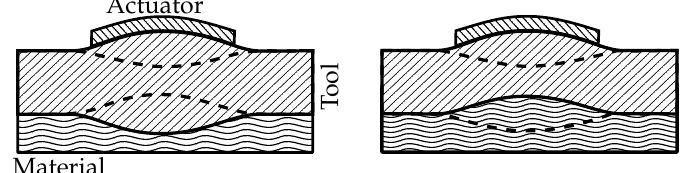
Figure 1. Different resonance types below the actuator. (symmetric, left; anti-symmetric, right).